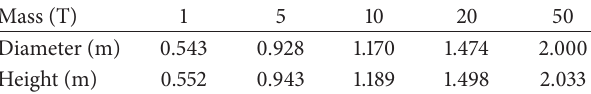
Table 2: Deformable impactors analysed.